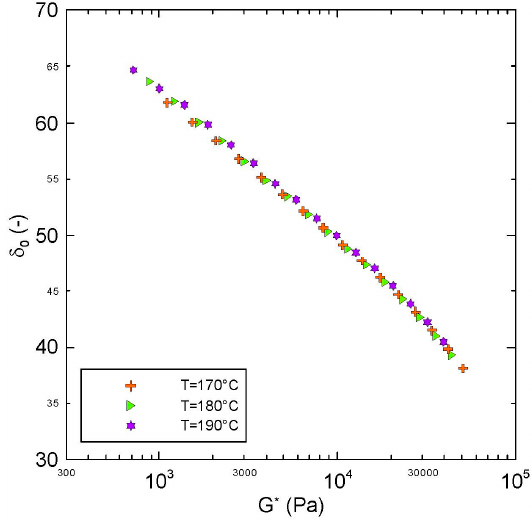
Figure 1. Van Gurp-Palmen plot for virgin polypropylene (PP).